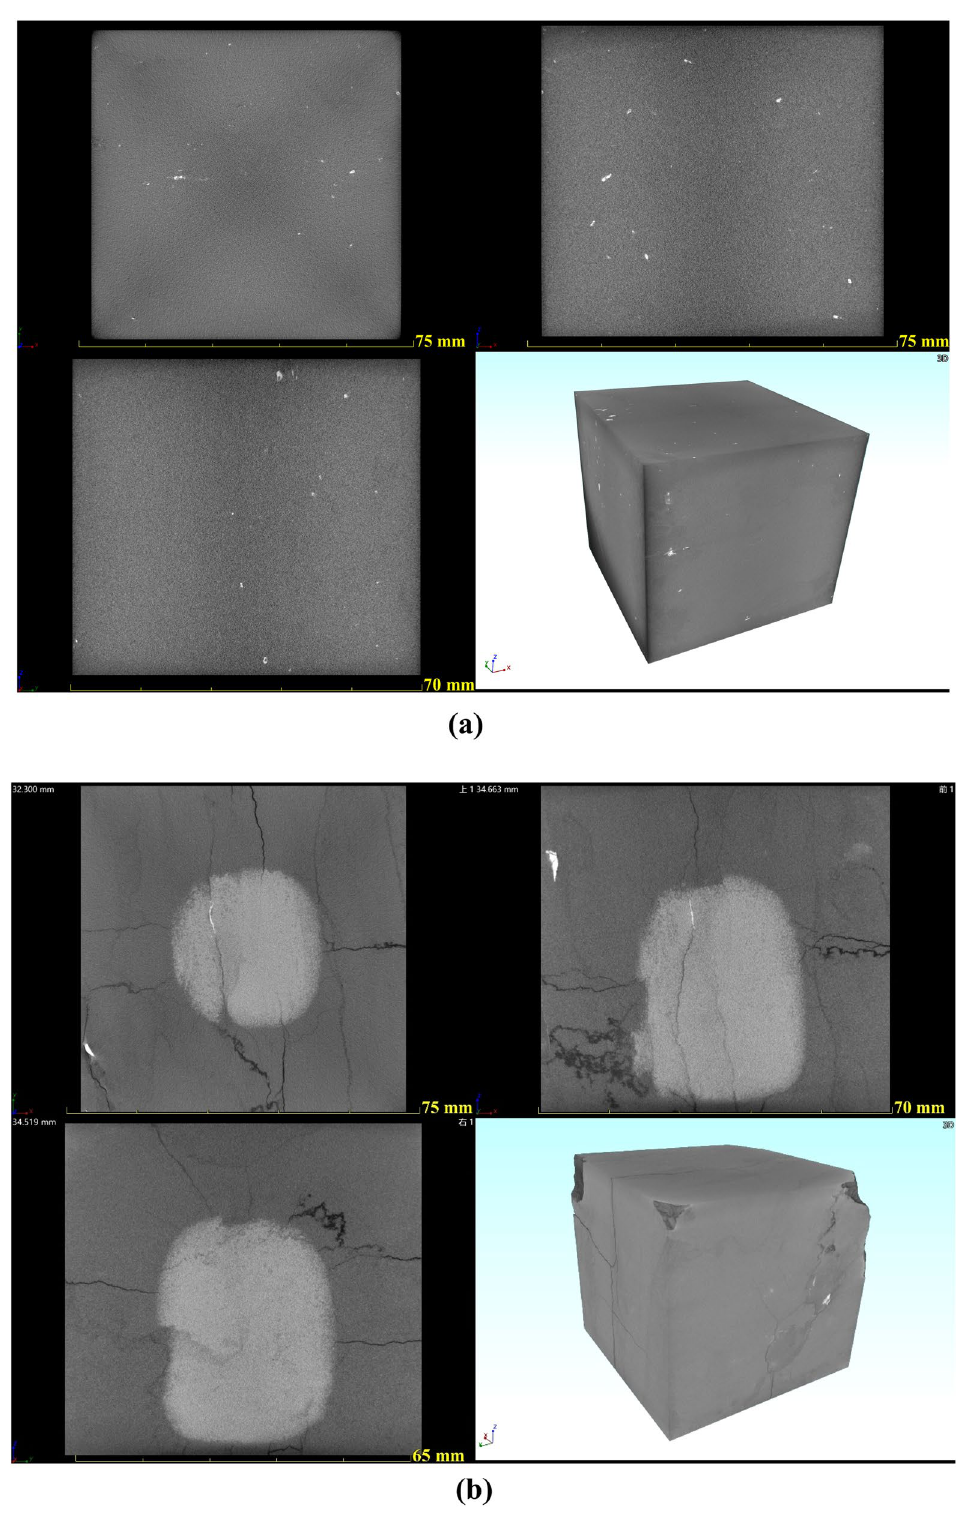
Figure 5. Four views of CT scan of limestone samples at typical temperatures: ( a ) 25 °C; ( b ) 1000